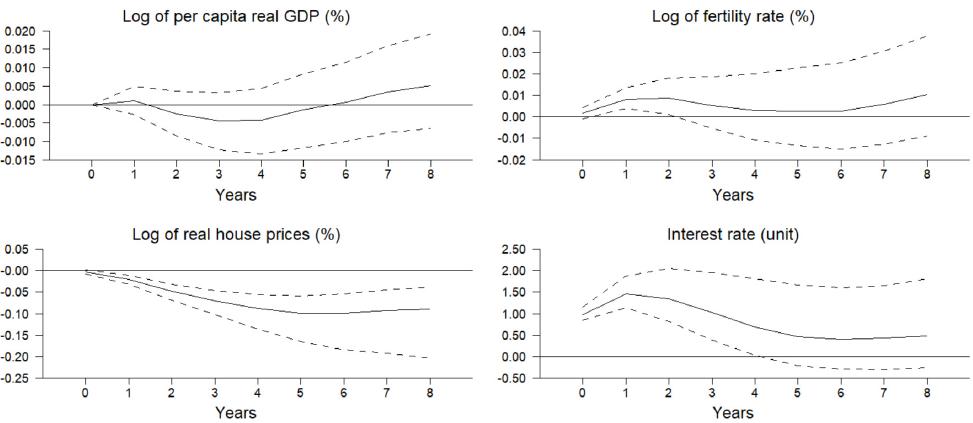
Figure 13. Responses to an interest rate shock in the baseline SVAR when the fertility rate is ordered last; additionally, the ordering of the interest rate and house prices are interchanged in the model .